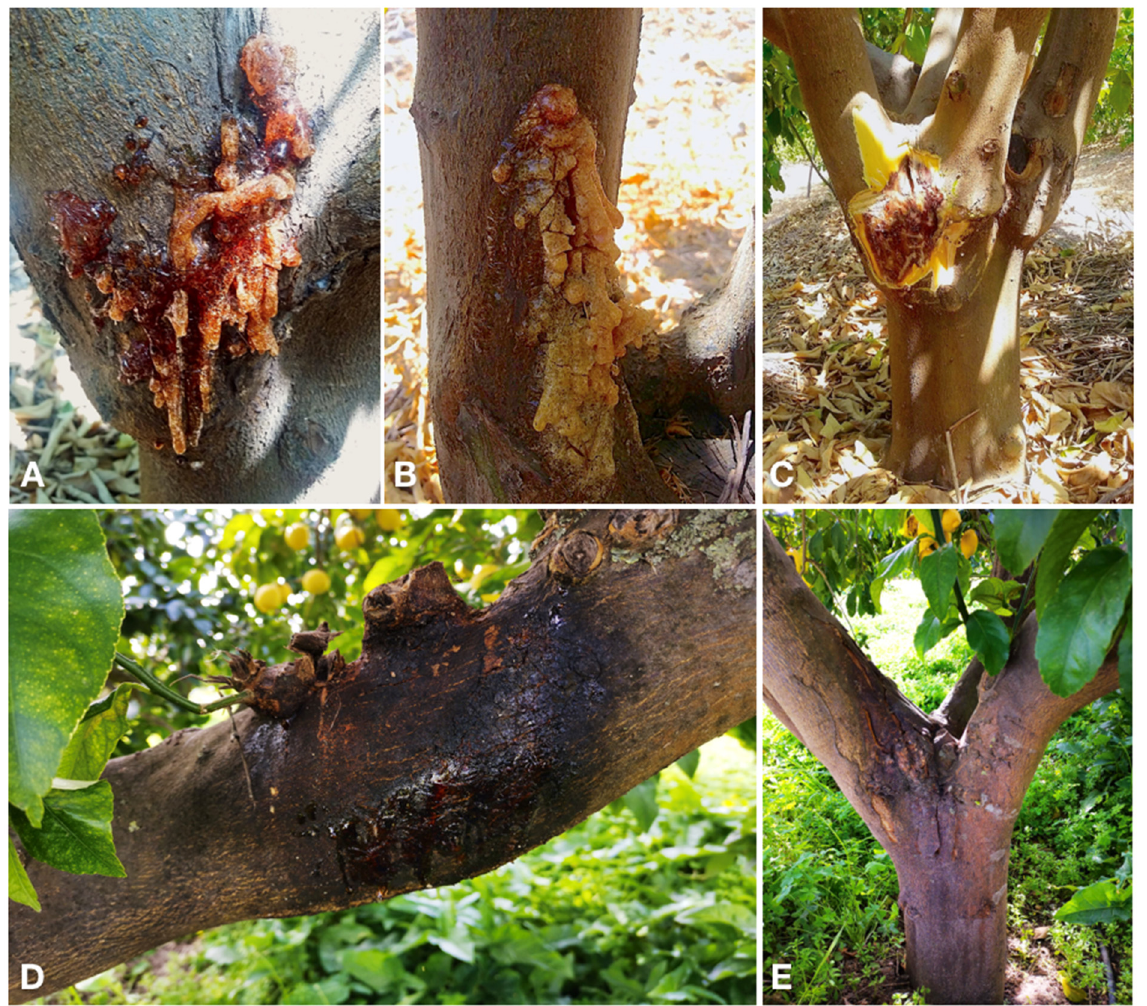
Figure 2. Symptoms of bot gummosis on lemon trees: ( A , B ) cankers with abundant gummous exudate on scaffold branches of ‘Femminello Siracusano 2Kr’ lemon ( Citrus × limon ) tree; ( C ) typical tan to brown discoloration of the wood beneath the bark of a canker; the discolored wood is visible after removing the bark; ( D ) gummous canker on a branch of lemon tree; ( E ) old canker with bark scaling at the level of main branch scaffolding, expanding upward to the secondary branches and downward to the grafting line between the scion and the rootstock.